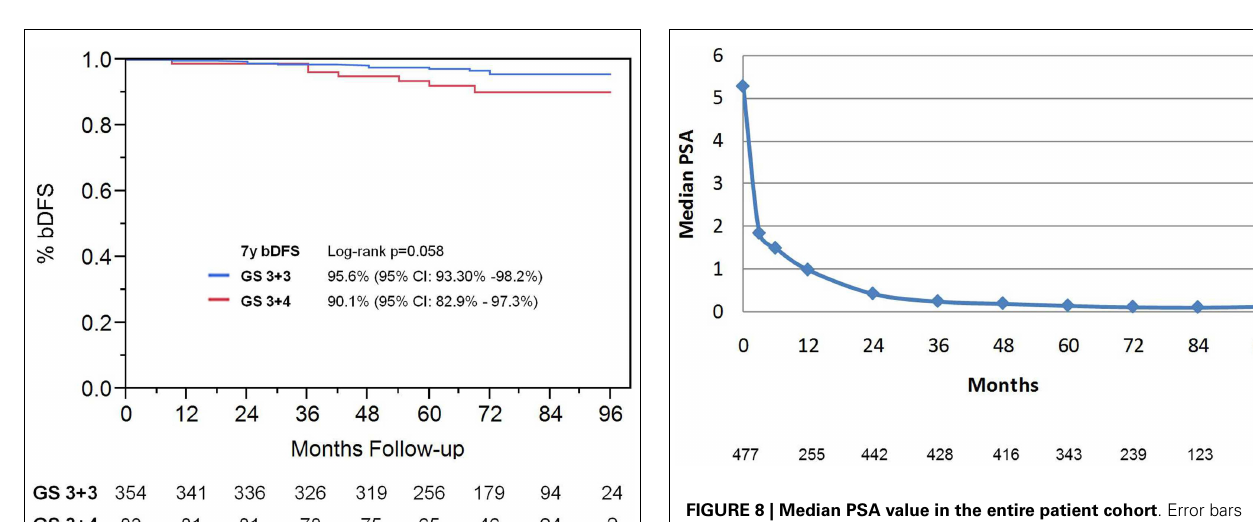
FIGURE 8 | Median PSA value in the entire patient cohort . Error bars reflect interquartile range.The Number of patients with PSA data at each time point is listed below. Patients with biochemical recurrence are excluded.